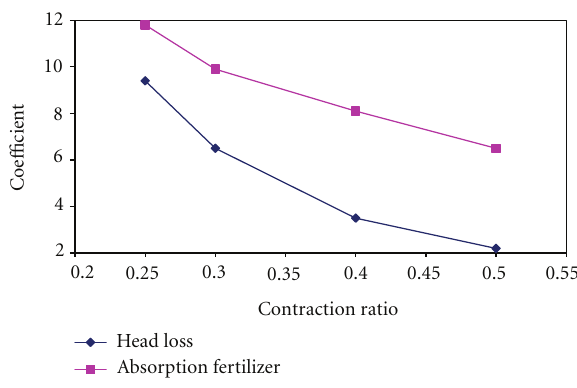
Figure 7: E ff ects of contraction ratio on head loss and absorption fertilizer of Venturi